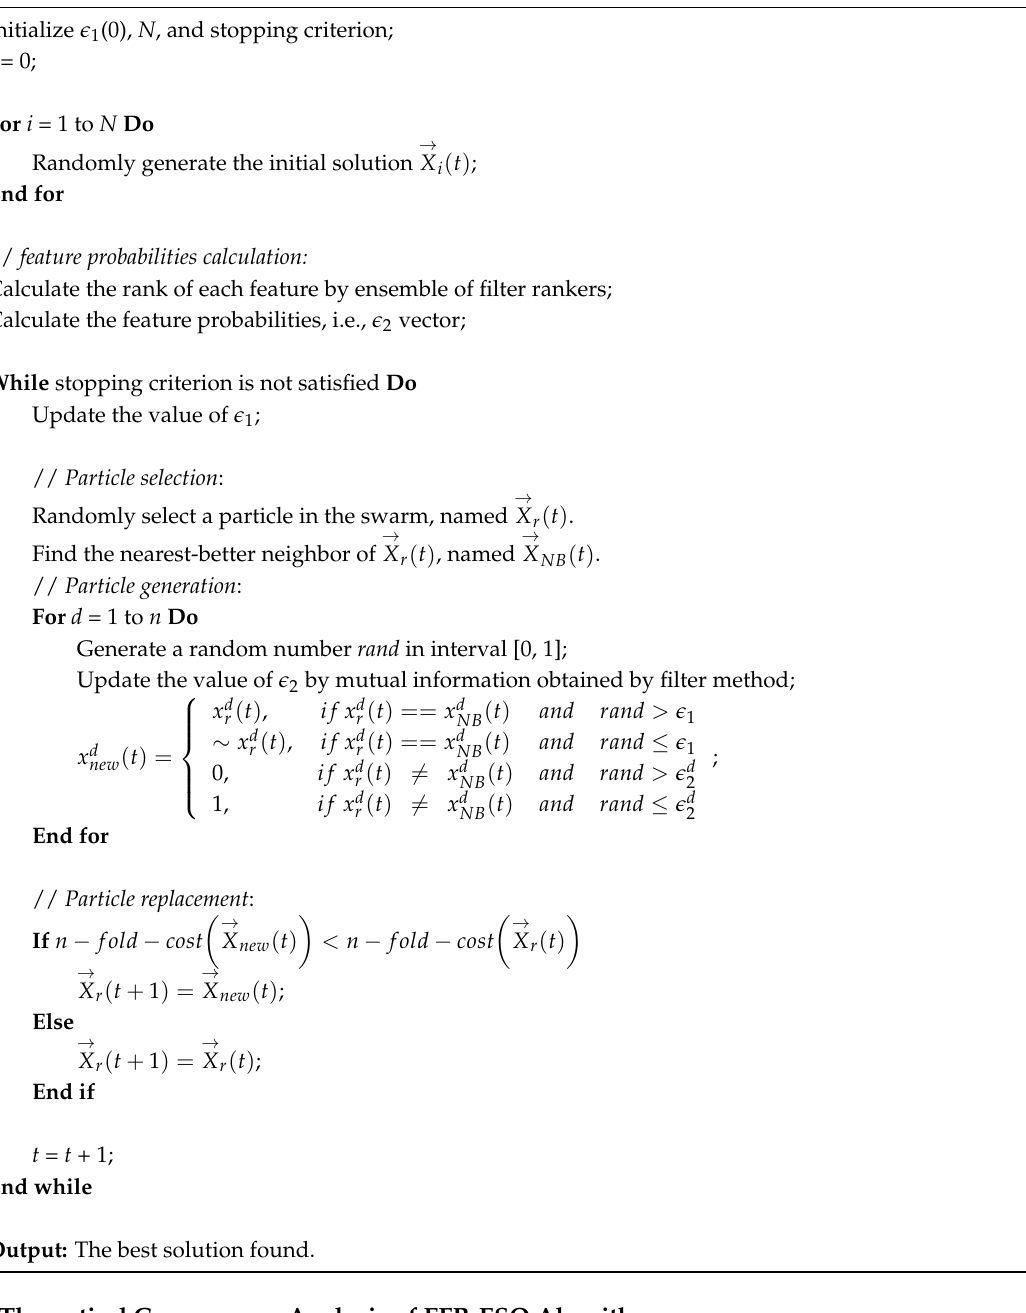
Algorithm 3: Outline of EFR-ESO for